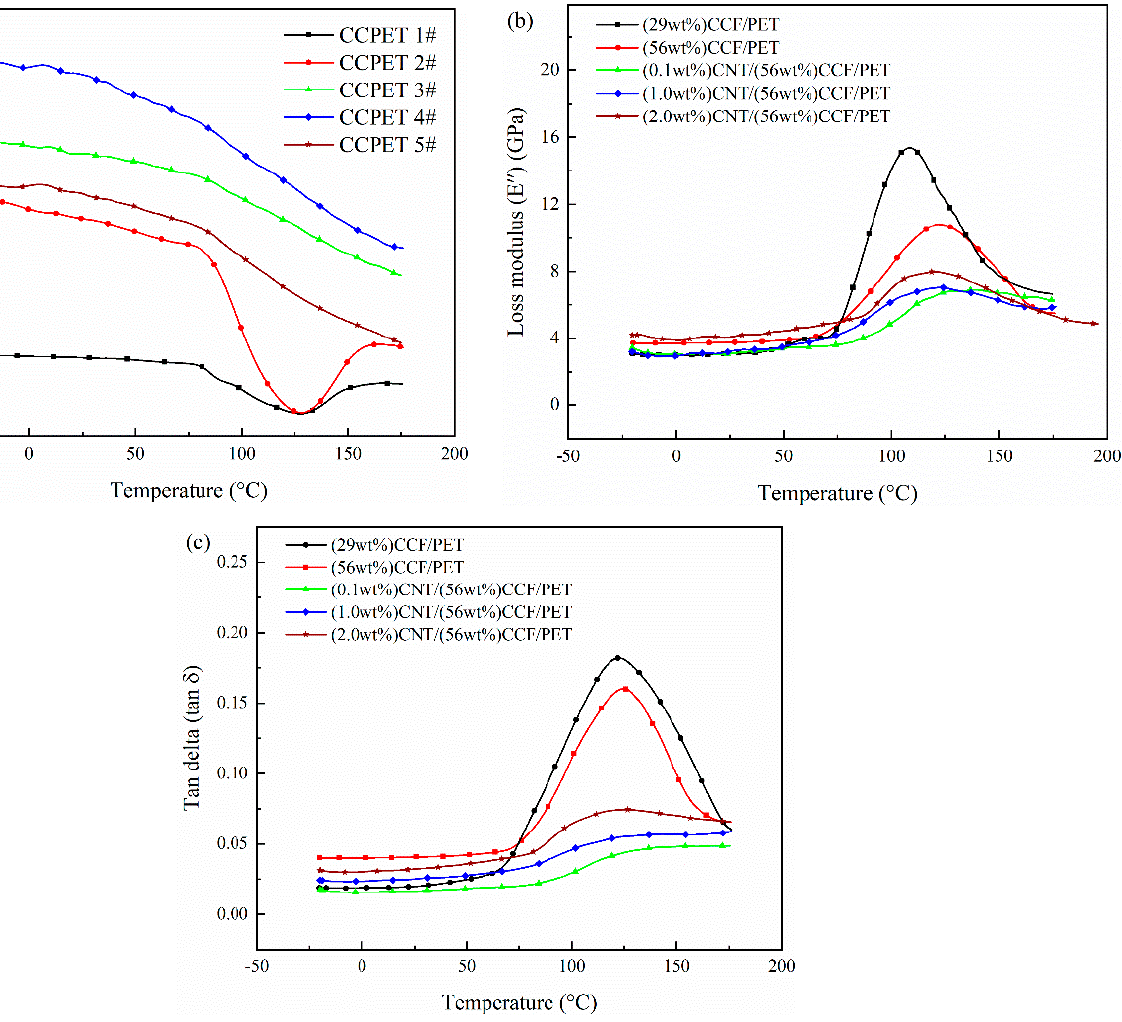
Figure 5. DMA test results of CNT/CCF/PET composites: ( a ) storage modulus, ( b ) loss modulus, ( c ) tan δ .